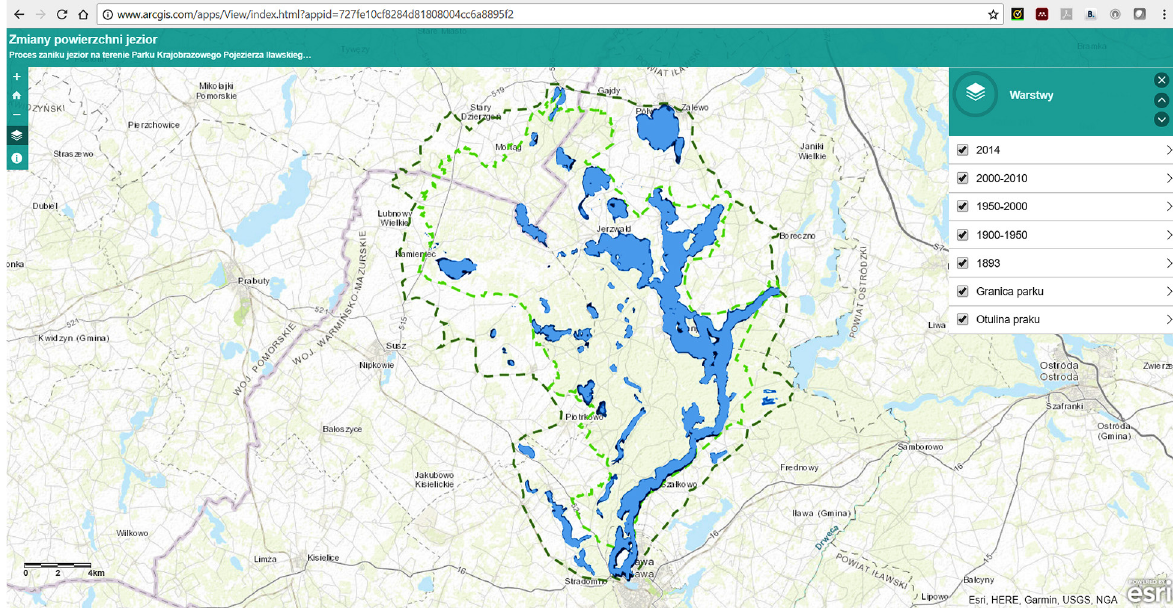
Fig. 5. Interactive map interface on the server of ArcGIS Online.